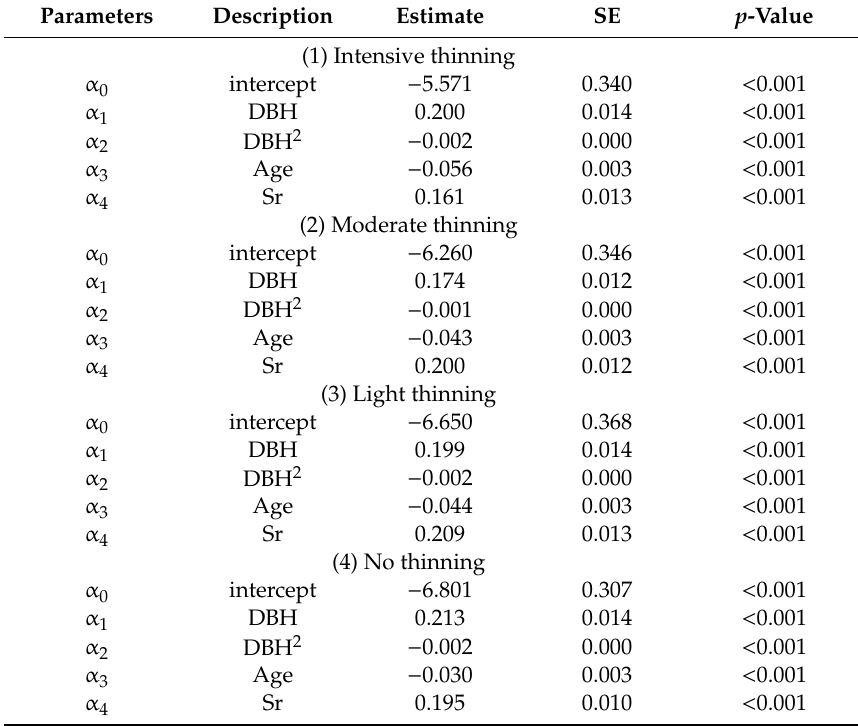
Table 4. Summary of parameter estimation using the relative spacing index (Sr) for the TDM model. Parameters